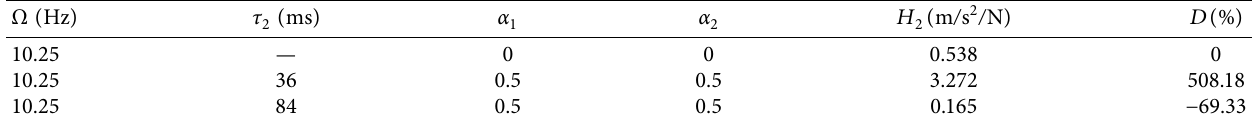
on the vibration suppression effect for Ω � 10 . 25 Hz and α 2